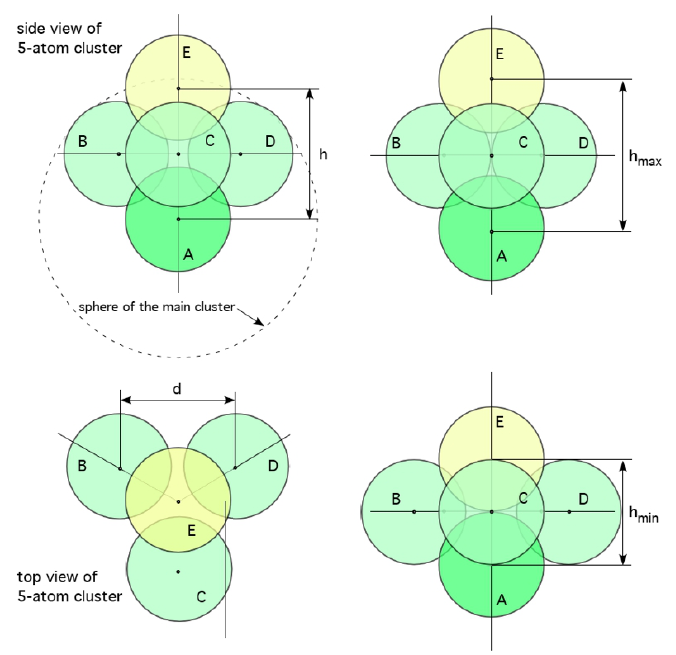
Figure 5. Models of atomic rearrangements in amorphous solids not requiring vacancy-atom exchange. Top, in the α mechanism atoms B, C & D move towards each other whilst A & E separate. Bottom, in the β mechanism atoms A & E come close at the expense of B, C & D moving further apart [74]. It is conjectured that these mechanisms supply additional pathways allowing for structural and chemical rearrangements within clusters and